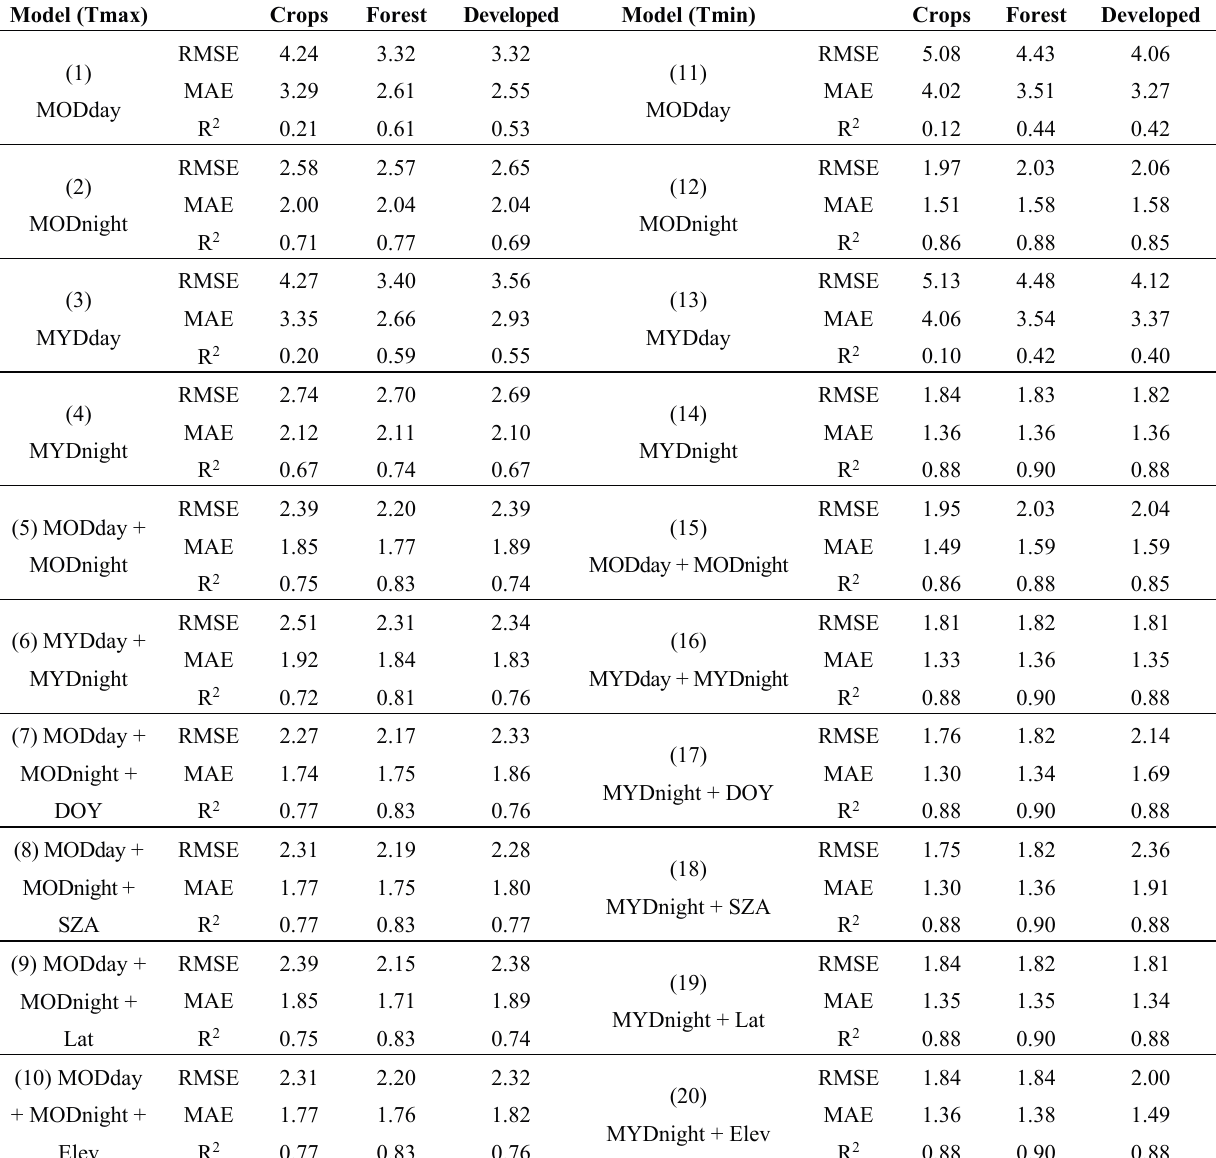
Table 2. Model variables and validation accuracy for Tmax and Tmin